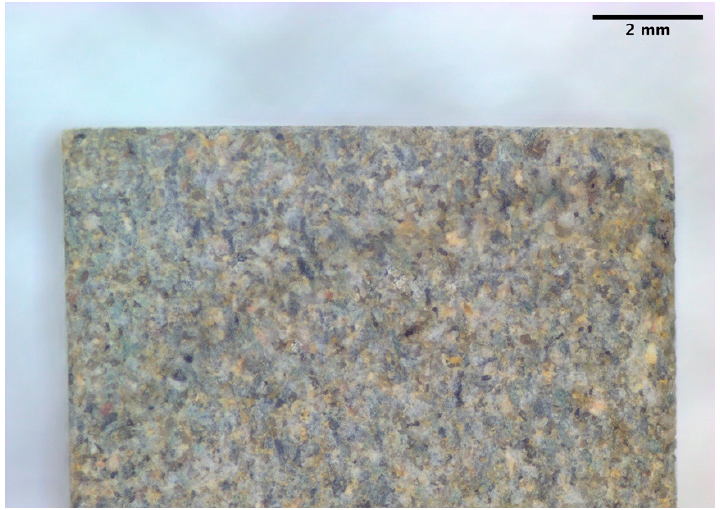
Figure 1. Picture of one rock samples. The image has been obtained through the optical setup described in the text.